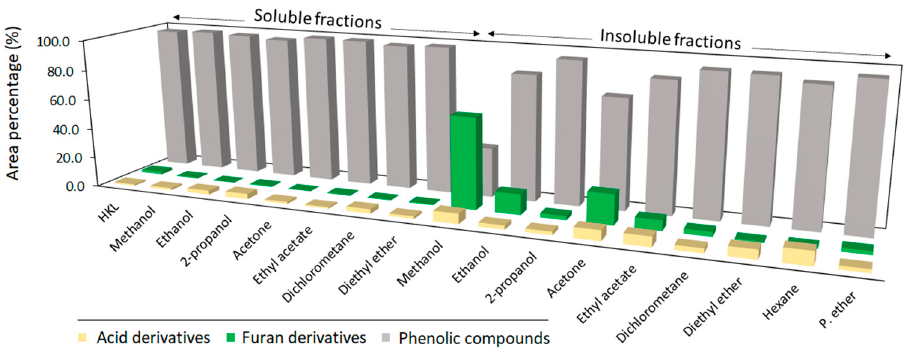
Figure 2. Relative content of identified pyrolysis products according to their origin. Table 2. Relative content (%) of phenolic-type compounds according to their structural characteris- tics and S/G ratio.